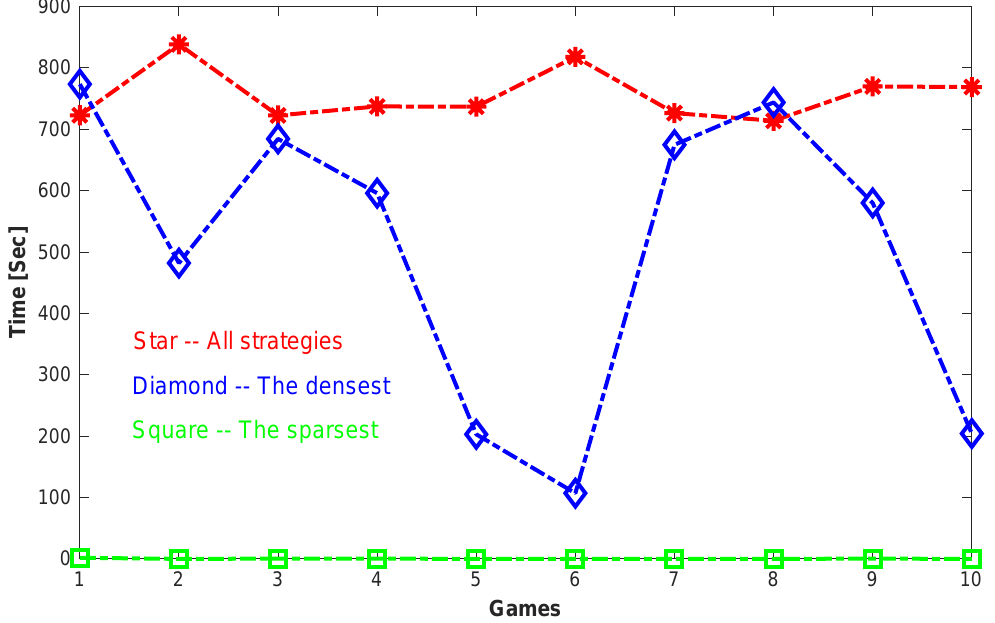
Figure 1. Performance Results: The computing times for obtaining all the equilibrium strategies, the densest, and the sparsest for 10 randomly generated games using the complete, sparse, and dense Shapley-Snow algorithms,